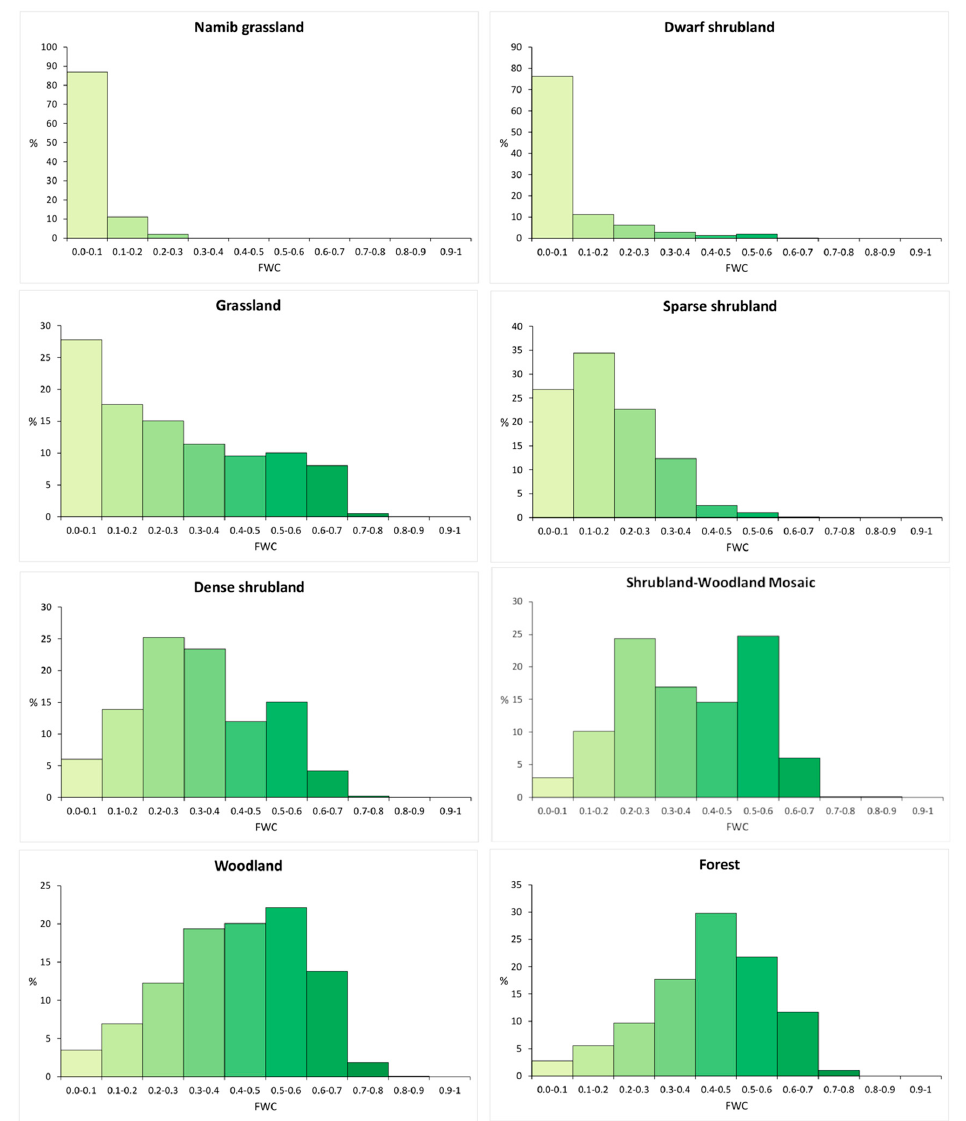
Figure 9. Histograms of fractional woody cover (FWC) within dominant vegetation structure classes (Figure 1C) based on FWC2016 50mSAR+MAP .